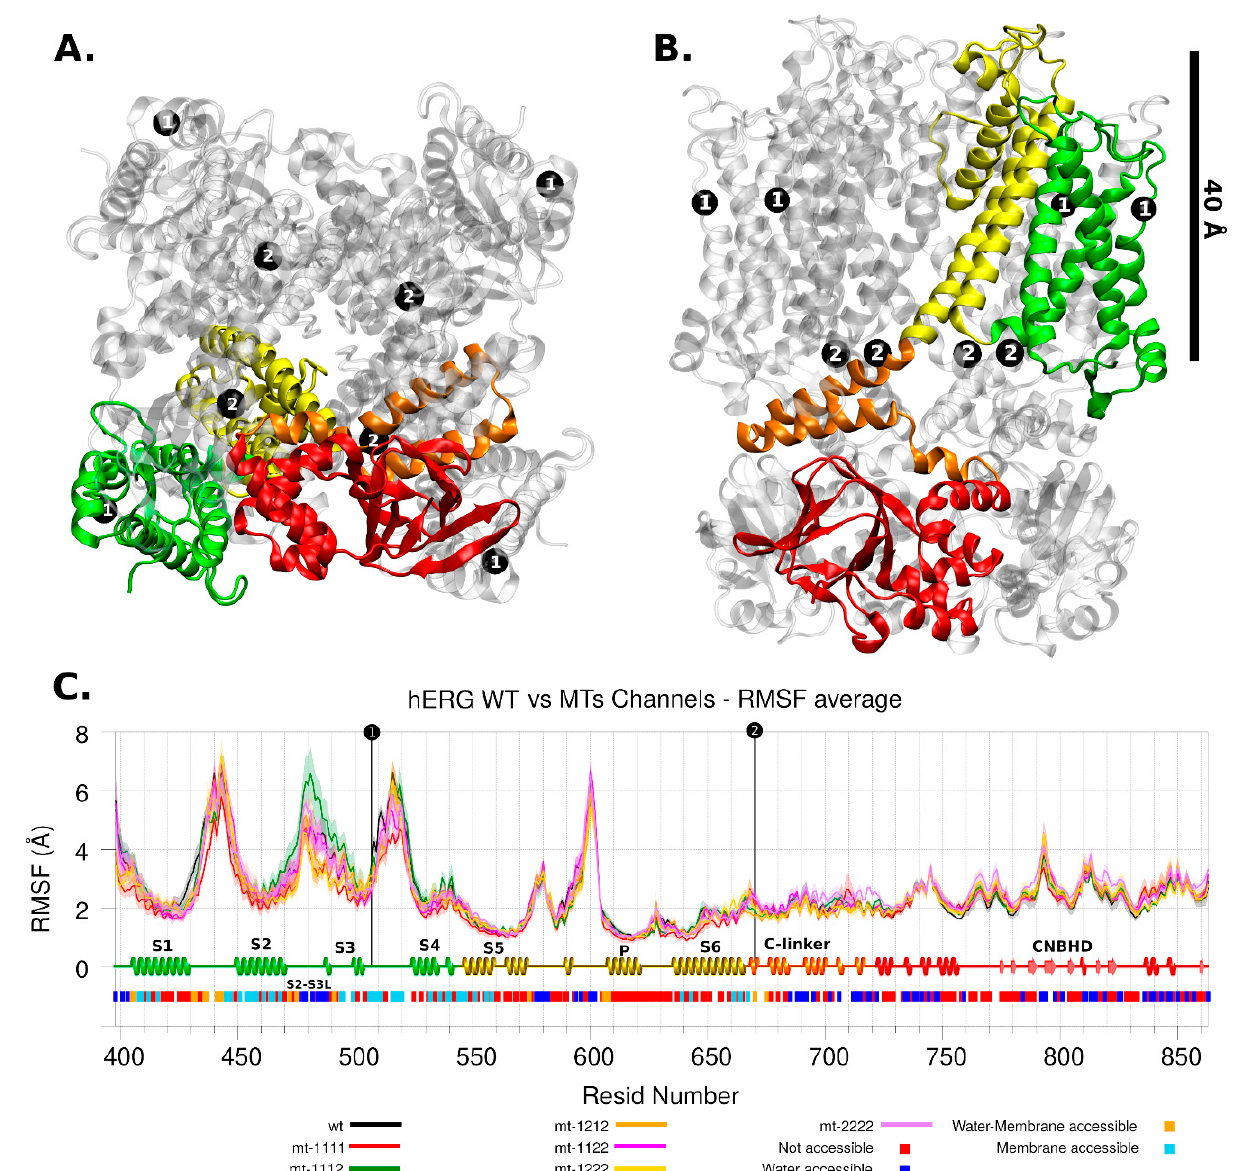
Figure 4. hERG Channel. The mutation location is shown with black dots and number 1 or 2. Four protein domains are shown in colors: intermembrane (green and yellow), inner side of the membrane (orange and red). ( A ) Top view. ( B ) Lateral view. ( C ) RMSF analysis for wild and mutant types. Each series corresponds to 4 chains and 4 replicas for each one, then it shows its average and standard deviation. The secondary structure motifs and solvent accessibility are shown below.